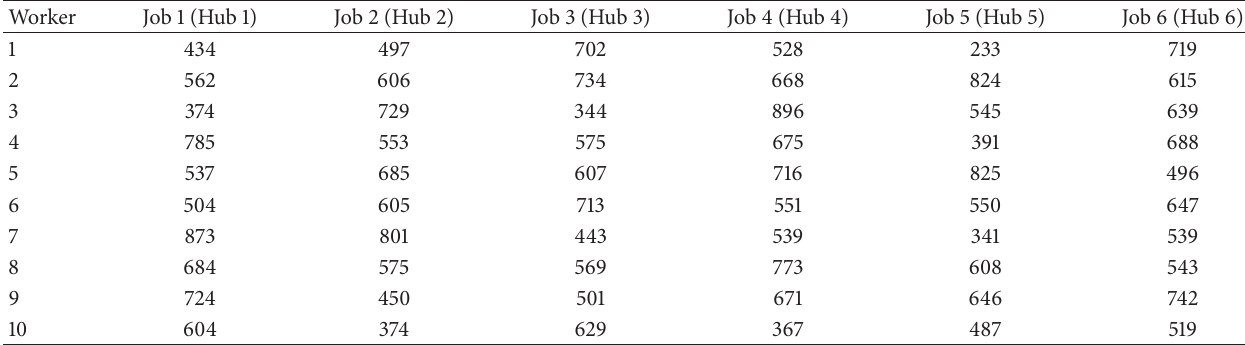
Table 5: The total cost incurred for each worker on training each job